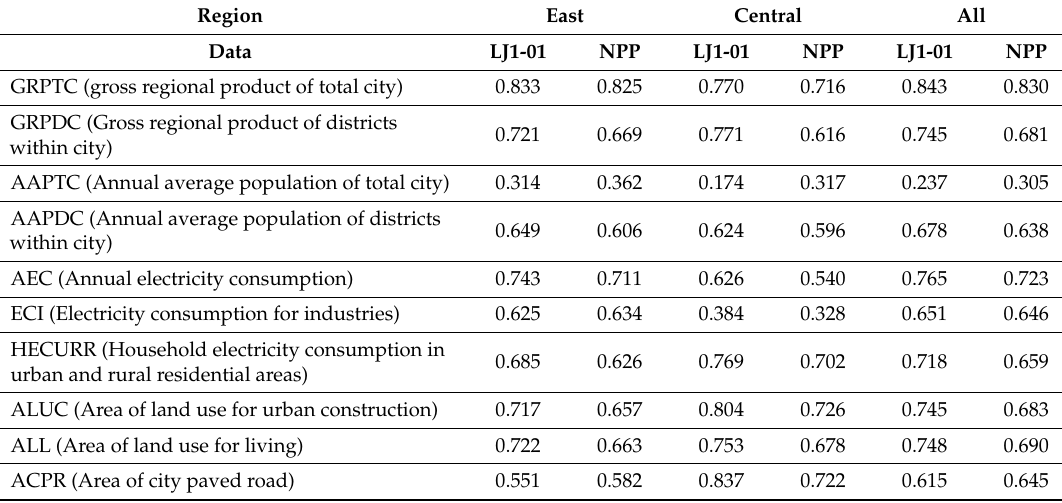
Table A1. Comprehensive listing of linear regression R 2 values for TNL and GRP (Table 3), TNL and population (Table 4), TNL and electricity consumption (Table 6), and TNL and area of land used (Table